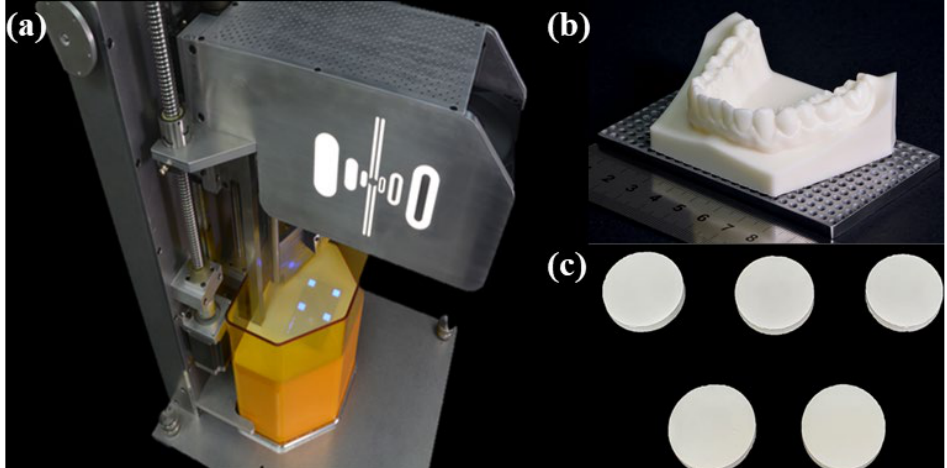
Figure 2. DLP machine used for preparing zirconia samples: ( a ) DLP machine curing formulations; ( b ) mandible and teeth model manufactured using DLP machine; ( c ) zirconia disk samples manufactured by DLP machine.